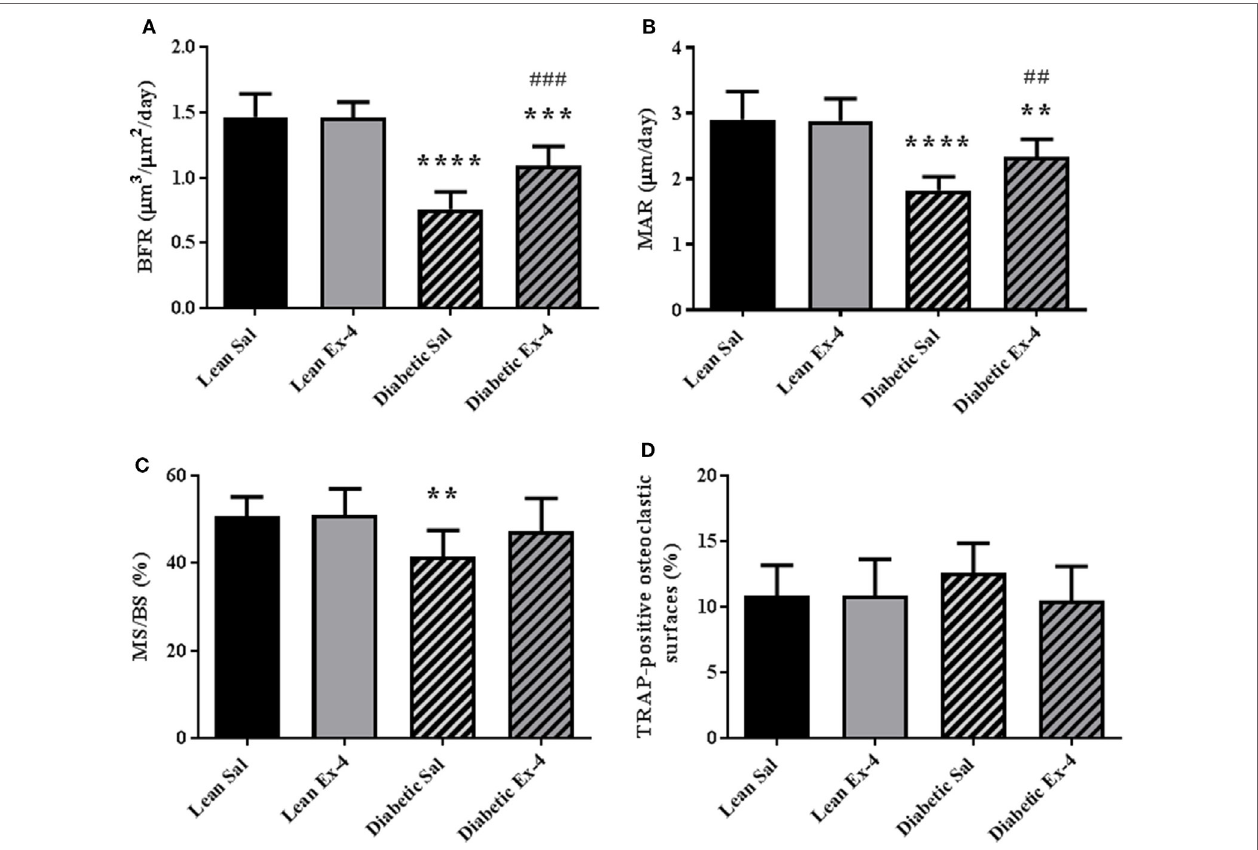
FigUre 3 | Effect of Exenatide on bone turnover parameters in db/db and control mice. Measurements were performed by bone histomorphometry on the trabecular region of tibial sections from 13-week-old db/db and lean mice treated with either Exenatide (10 μ g/kg/day) or saline. (a) Bone formation rate (BFR). (B) Mineral apposition rate (MAR). (c) Mineralizing surfaces MS/BS. (D) Tartrate-resistant acid phosphatase (TRAP)-positive osteoclastic surfaces per millimeter of trabecular bone surface. Bars represent mean ± SD of n = 10 mice/group, ** P < 0.01, *** P < 0.001, **** P < 0.0001 versus lean Sal; ## P < 0.01, ### P < 0.001 versus diabetic